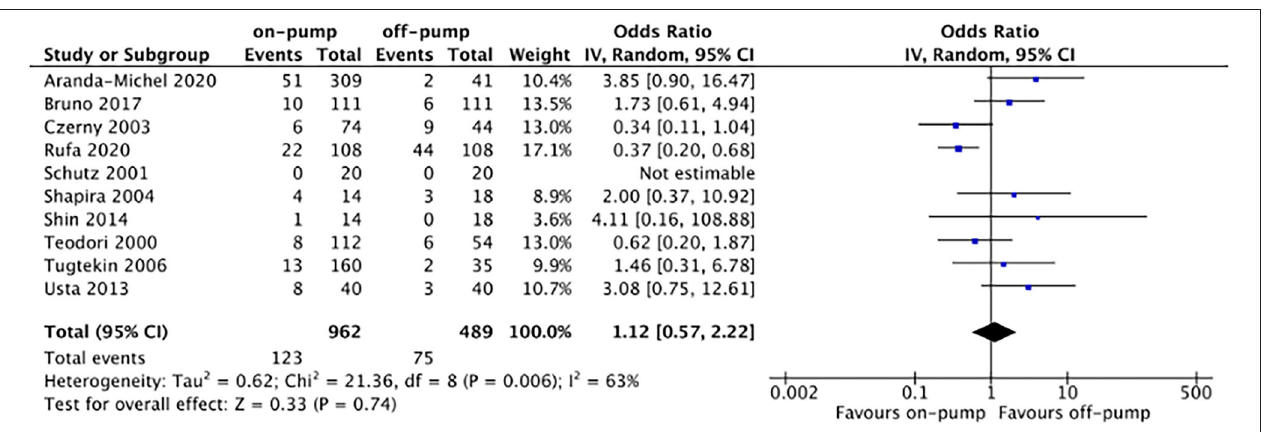
FIGURE 8 | Forest plot for mid-term